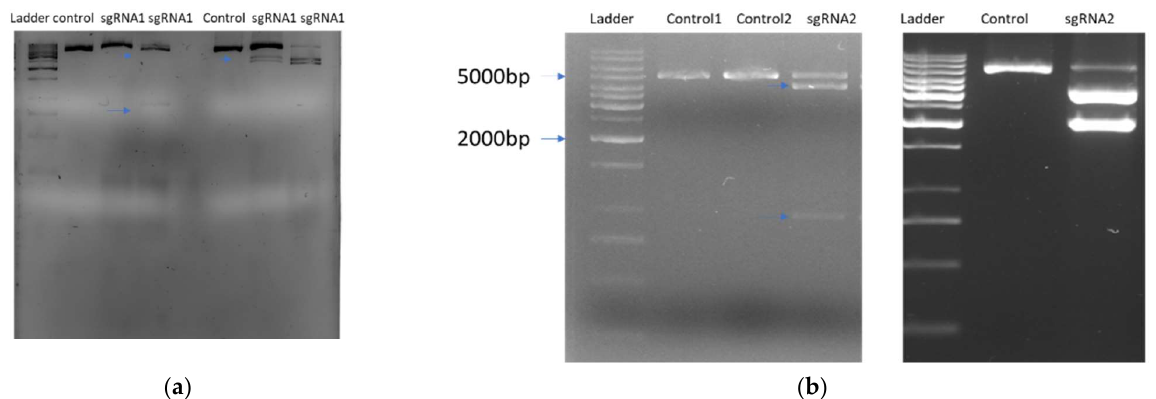
Figure 3. Results of in vitro digestion cleavage assay of both sgRNA sets for 4CL and RVE7 gene. ( a ) sgRNA 1 for 4CL and RVE7 . The DNA of 5 kb PCR-amplified fragments for gene 4CL and RVE7 were treated with preassembled RNPs (sgRNAs (crRNA/tracrRNA) + Cas9) and in vitro cleavage assay was performed. For in vitro cleavage assay non-treated samples were used as negative controls in gel electrophoresis. ( b ) sgRNA 2 for 4CL and RVE7 . The digested samples for 4CL left side and RVE7 at right side. Above lane 2,3,4 correspond to 4Cl and lane 6,7,8 for RVE7 samples. The expected band size for sgRNA 1 RVE7 were approximately 2298 and 3543; sgRNA 2 4469 and 1363. For 4CL the expected band sizes after digestion for sgRNA1 were 4931 and 1170; sgRNA 2 approximately 4477 and 1428.